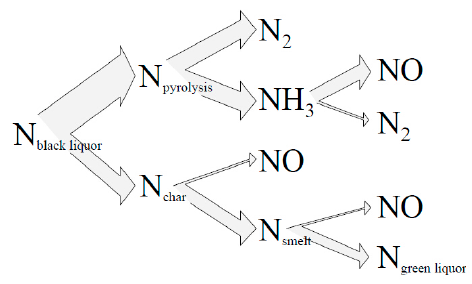
Figure 3. Thermal conversion pathways of fuel nitrogen [30].